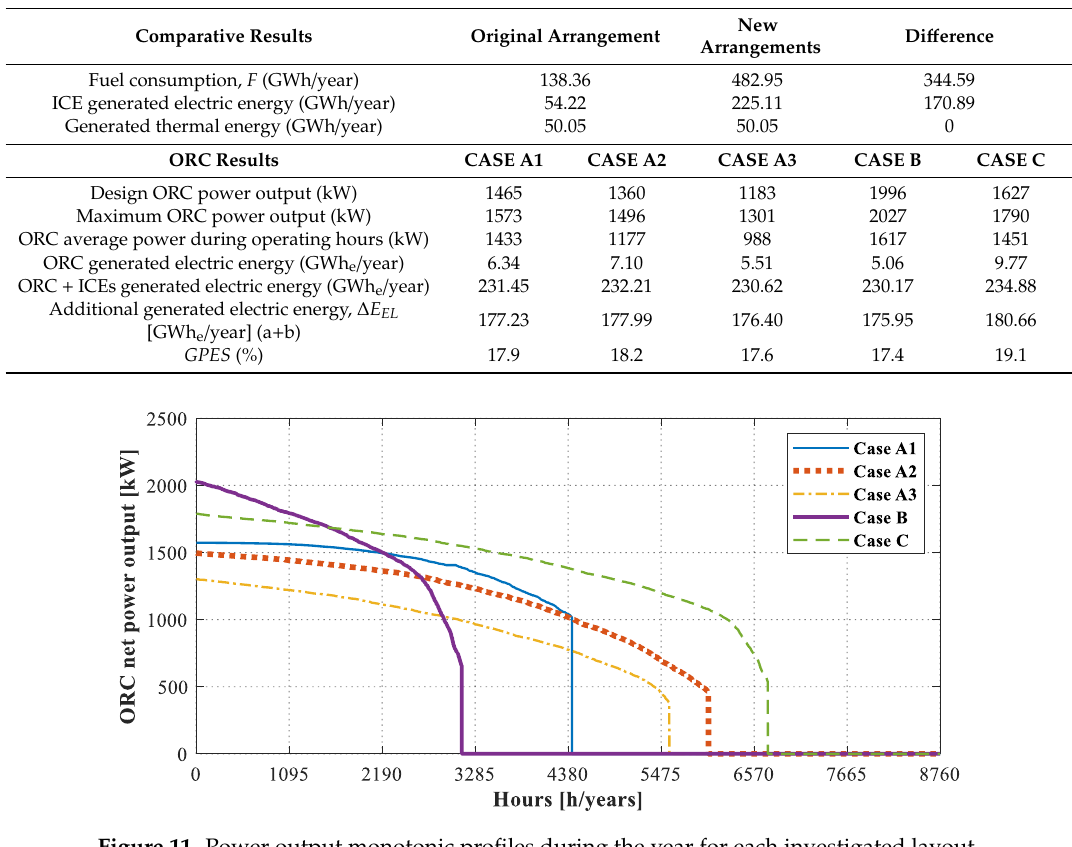
Figure 11. Power output monotonic profiles during the year for each investigated layout.